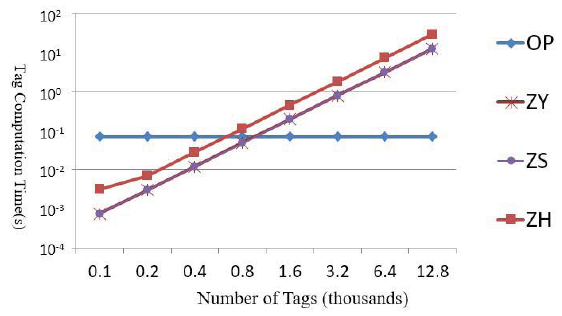
Figure 7. Comparisons of computation loads of tags.